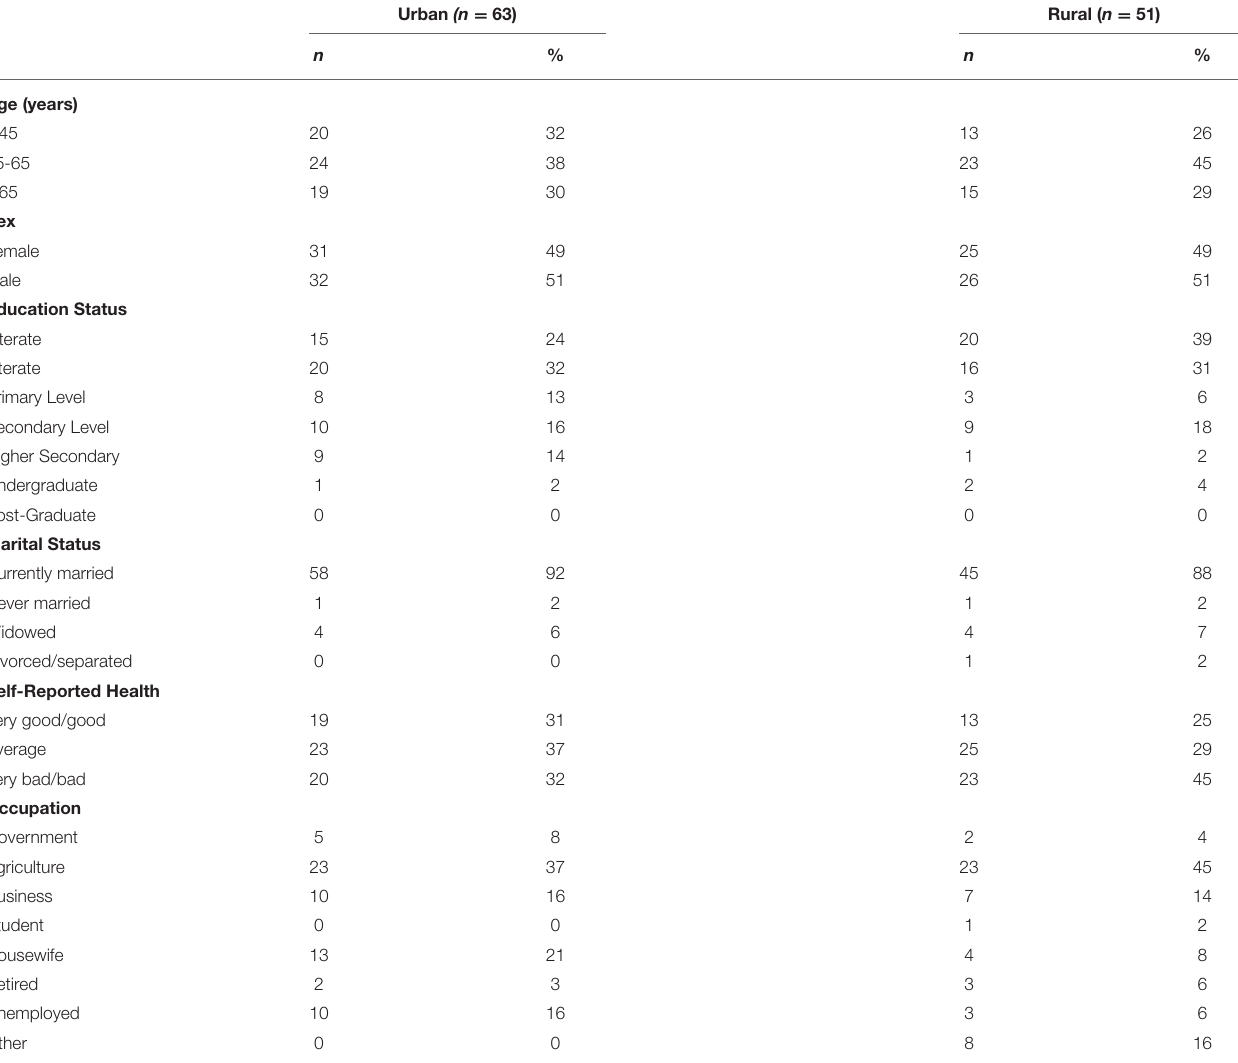
TABLE 1 | Participant sociodemographic profile.